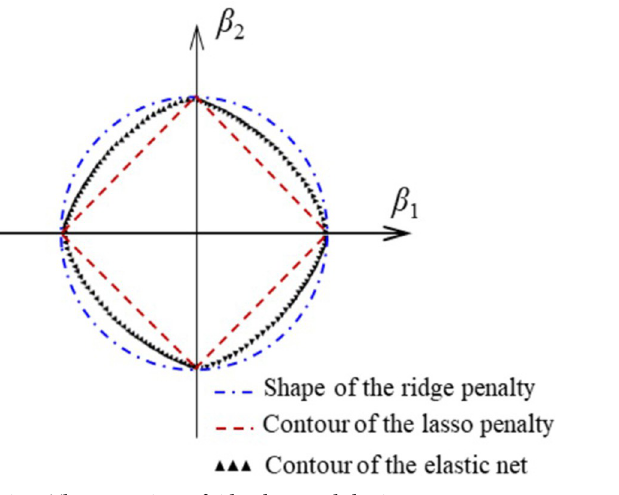
Fig 4. The comparison of ridge, lasso and elastic